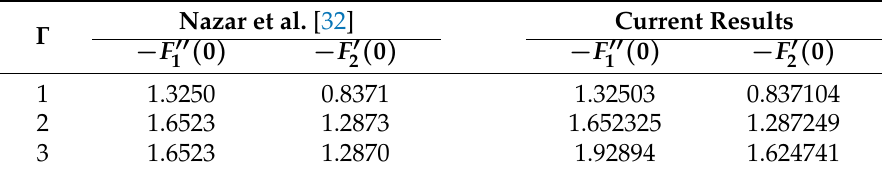
( 0 ) and F (cid:48) ( 0 ) against rotating parameter Γ when others involved 2 1